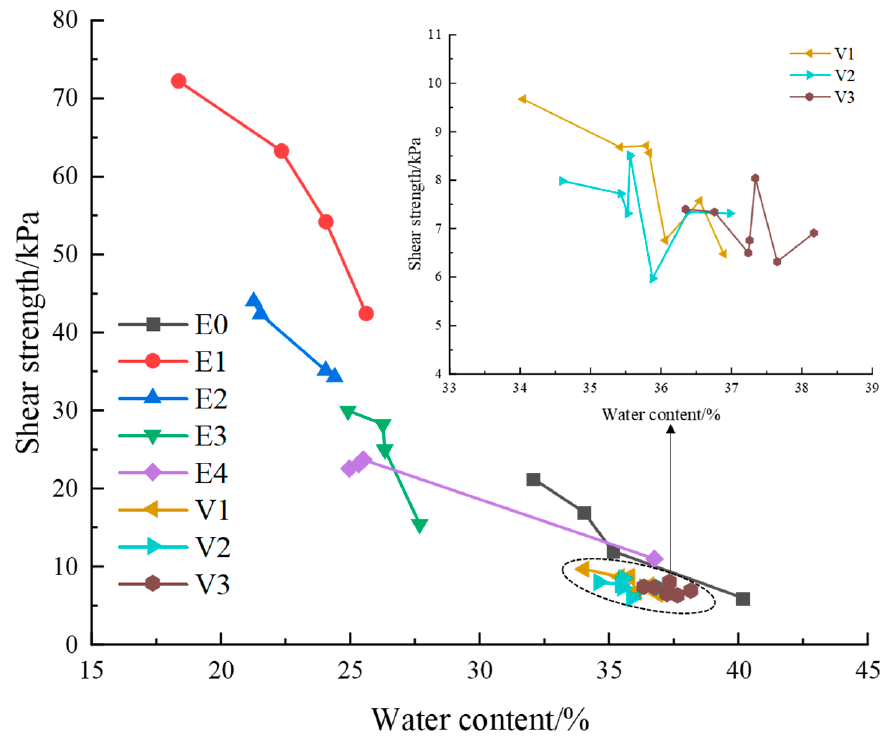
Figure 7. Relationship of shear strength with water content in each test.